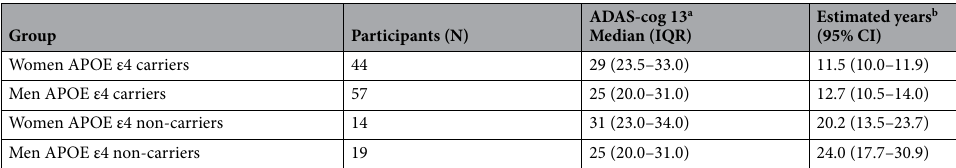
Table 2. Estimated time to reach AD dementia depending on APOE ε4 status by sex. We assigned the median ADAS-cog 13 score at the point of conversion from MCI due to AD to AD dementia to the equation for each sex and APOE ε4 combination to obtain the estimated converting year to AD dementia. ADAS-cog: Alzheimer’s disease assessment scale-cognitive subscale; APOE: apolipoprotein E; IQR: interquartile range; CI: confidence interval. a ADAS-cog 13 median (IQR) at the point of conversion from MCI due to AD to AD dementia. b Estimated years from preclinical AD to AD